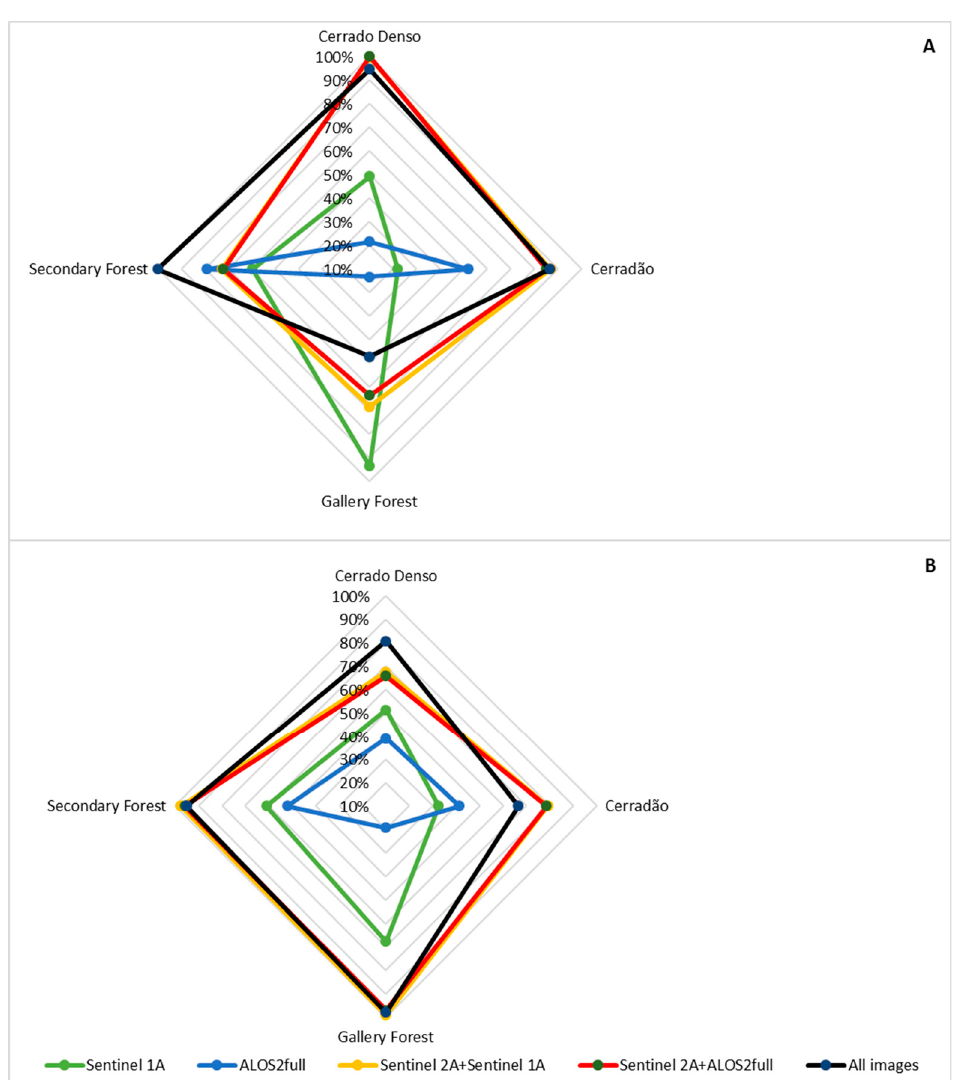
Figure 10. Producer’s ( A) and user’s ( B ) accuracy of classifications based on single-sensor and optical/SAR-combinations for the four Cerrado types. All data acquisitions during the dry and rainy season were considered.